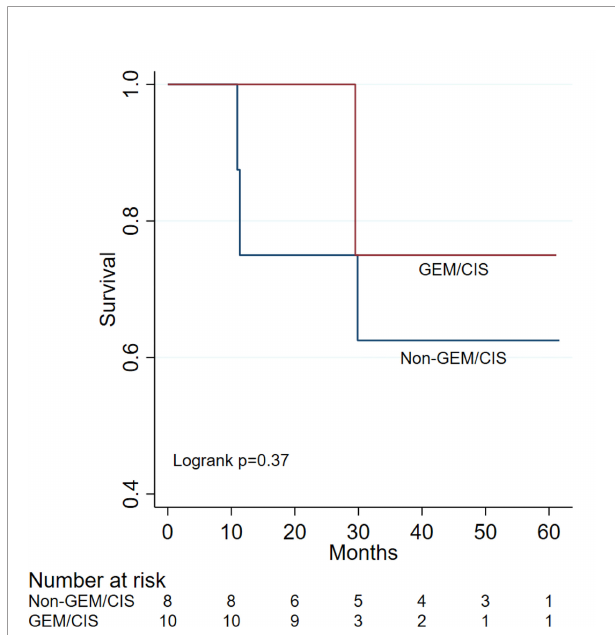
FIGURE 1 | Gemcitabine Plus Cisplatin Versus Non- Gemcitabine and Cisplatin as Neo-adjuvant for Treatment Cholangiocarcinoma Patients Prior to Liver Transplantation, the overall survival was 75% (95% CI 31-93%) at both years 1 and 2; 63% (95% CI 23-86%) at years 3 to 5 in the non-Gemcitabine/ Cisplatin group, but in the Gemcitabine/Cisplatin group, the overall survival was 100% (95% CI 100-100%) at both years 1 and 2; 75% (95% CI 13-96%) at both years 3 to